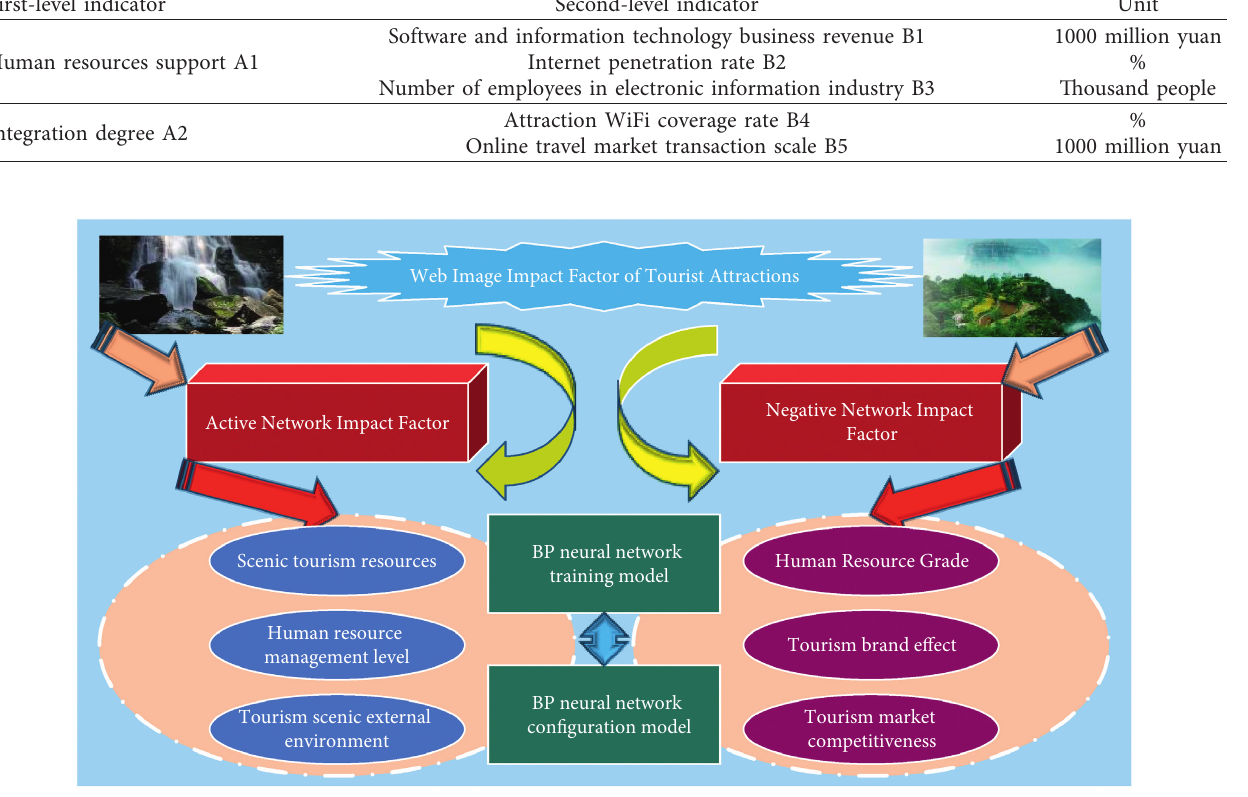
Table 1: The comprehensive evaluation system of tourism human resource allocation application development in the tourism industry. First-level